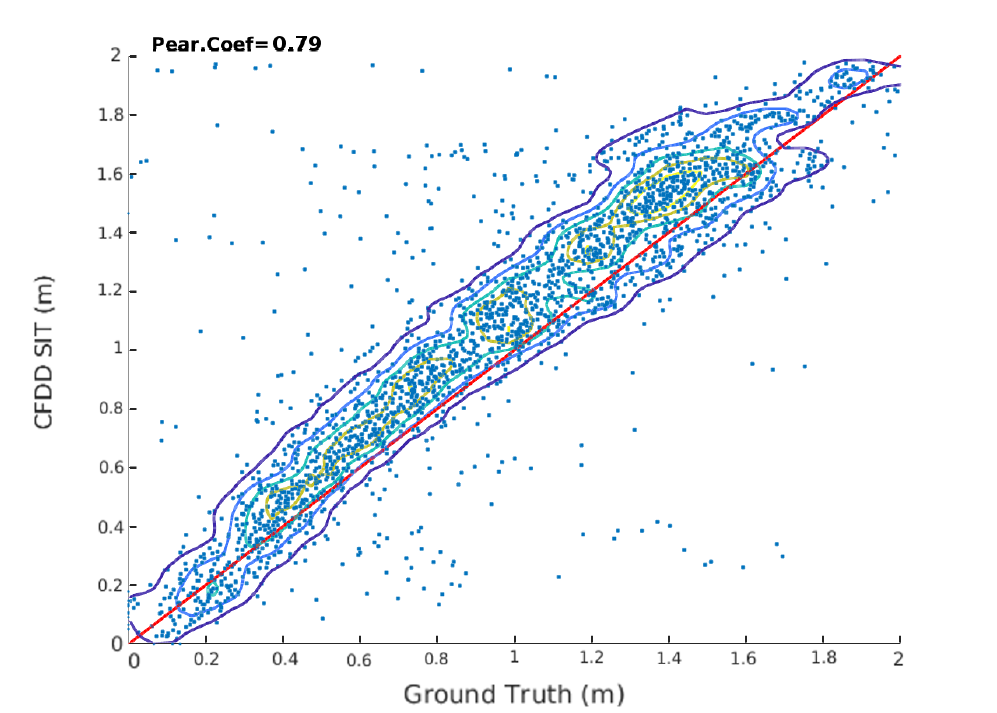
Figure 2. Comparison of the modeled CFDD Sea Ice Thickness (SIT) and the ULS ground truth. Contour lines in scatter plots herein describe the normalized density surface. Contours show a 20% step increase in density in all cases. Pearson’s correlation coefficient used herein is defined as the covariance of two variables divided by the product of their standard